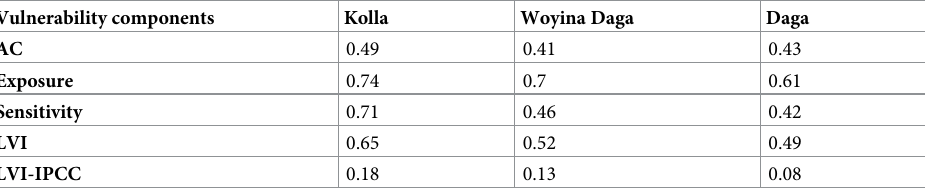
Table 8. LVI/ LVI-IPCC contributing factors across agro-ecology.